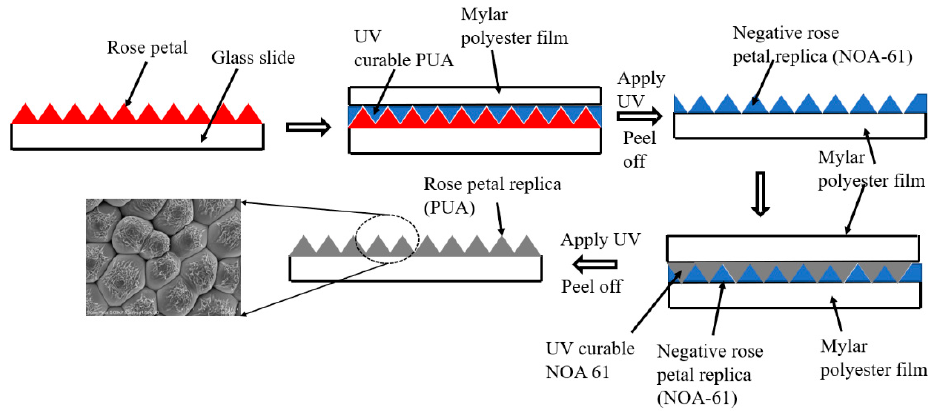
Figure 1. Schematic demonstrating the procedure used to produce rose petal structures on PUA film.